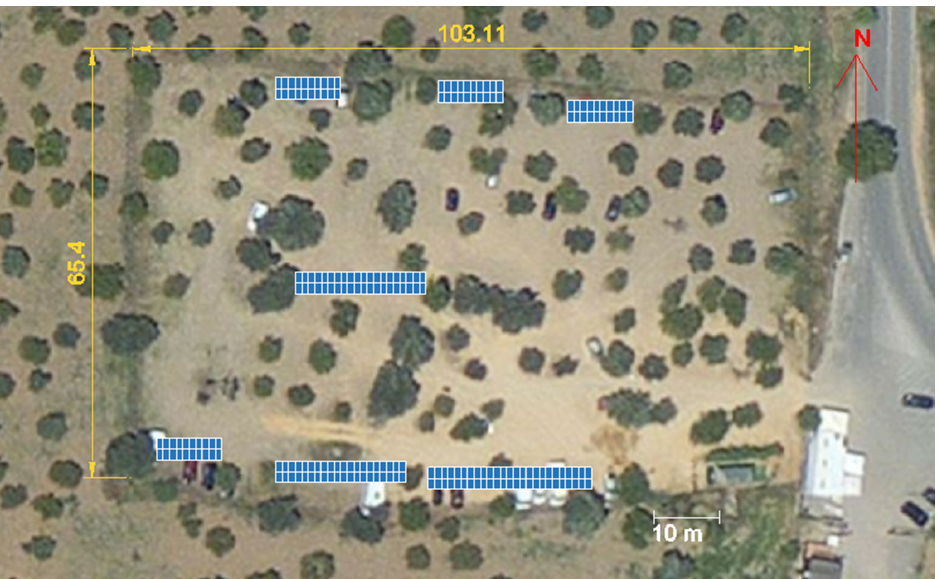
Figure 12. Plan of the parking area and of the PV shading structures.